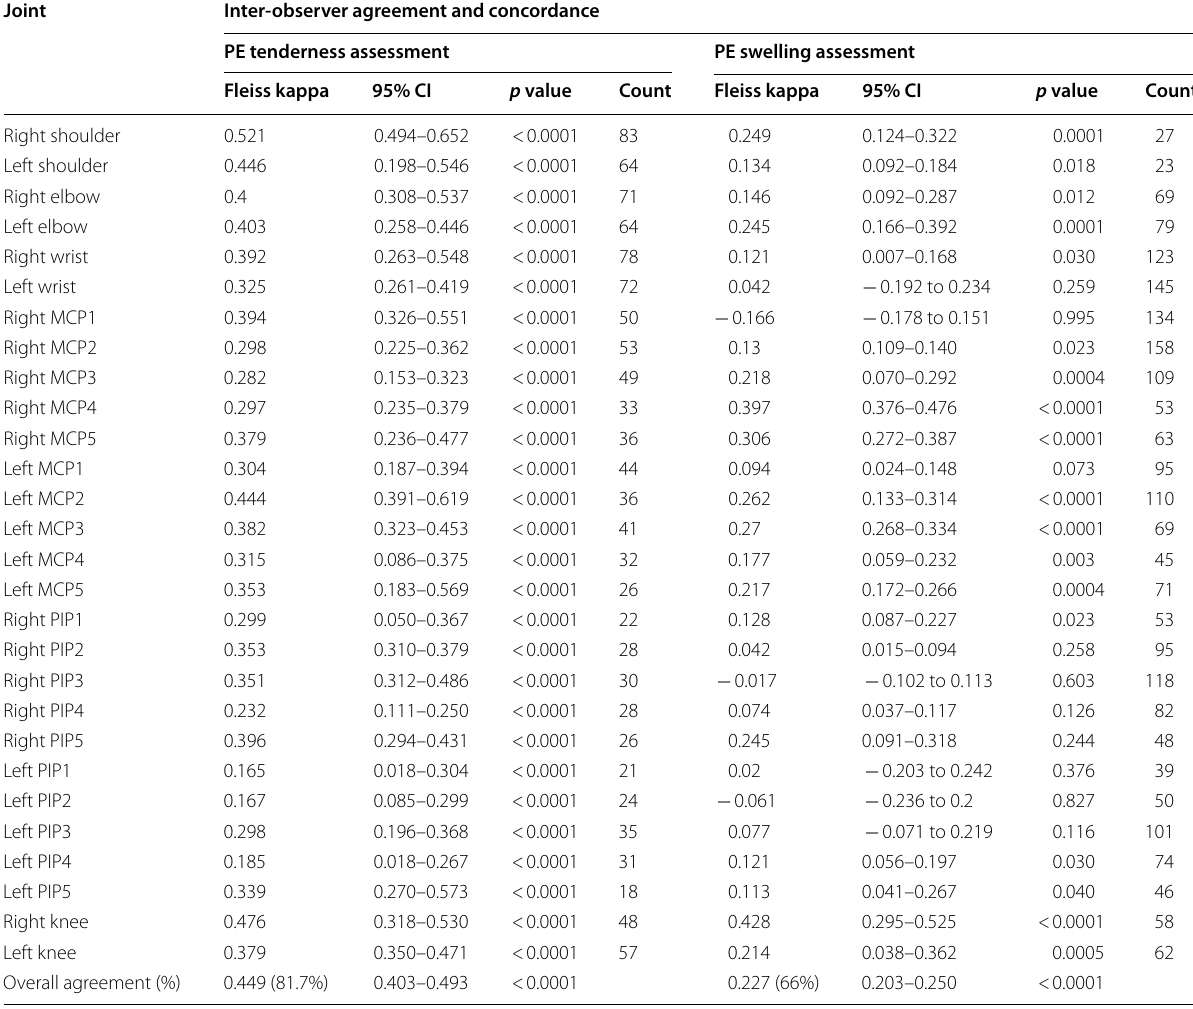
Table 2 Interobserver agreement and concordance for physical examination (PE) tenderness and swelling assessment